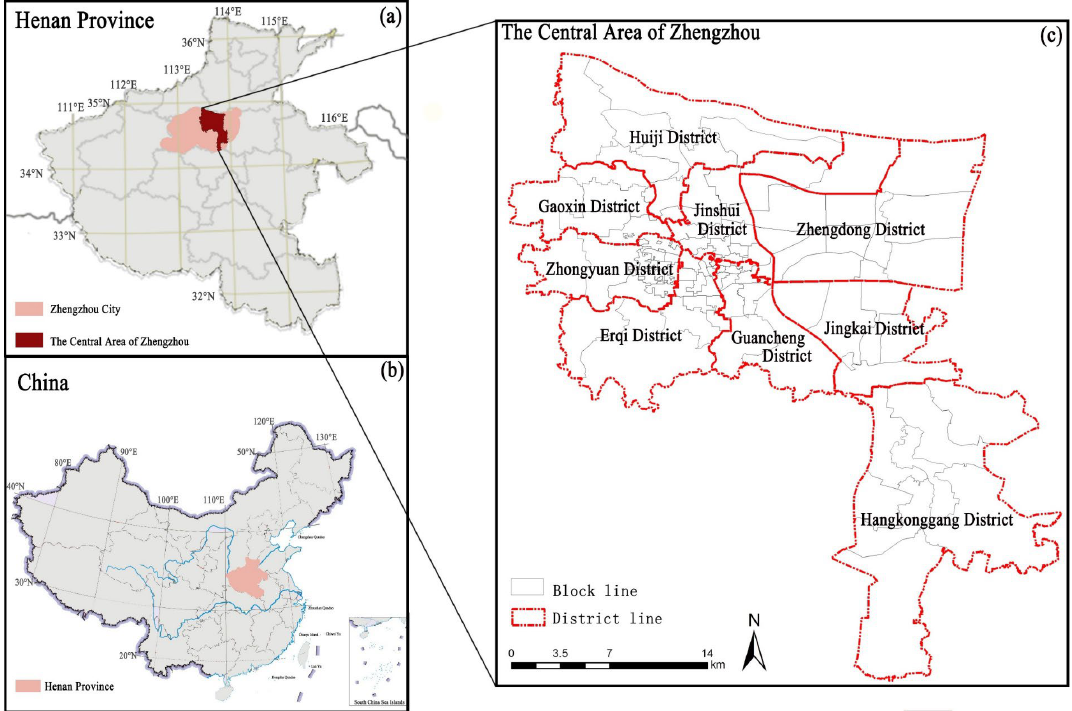
Figure 1. Administrative boundaries ( a ), geographic location ( b ) and topography ( c ) of Zhengzhou city.